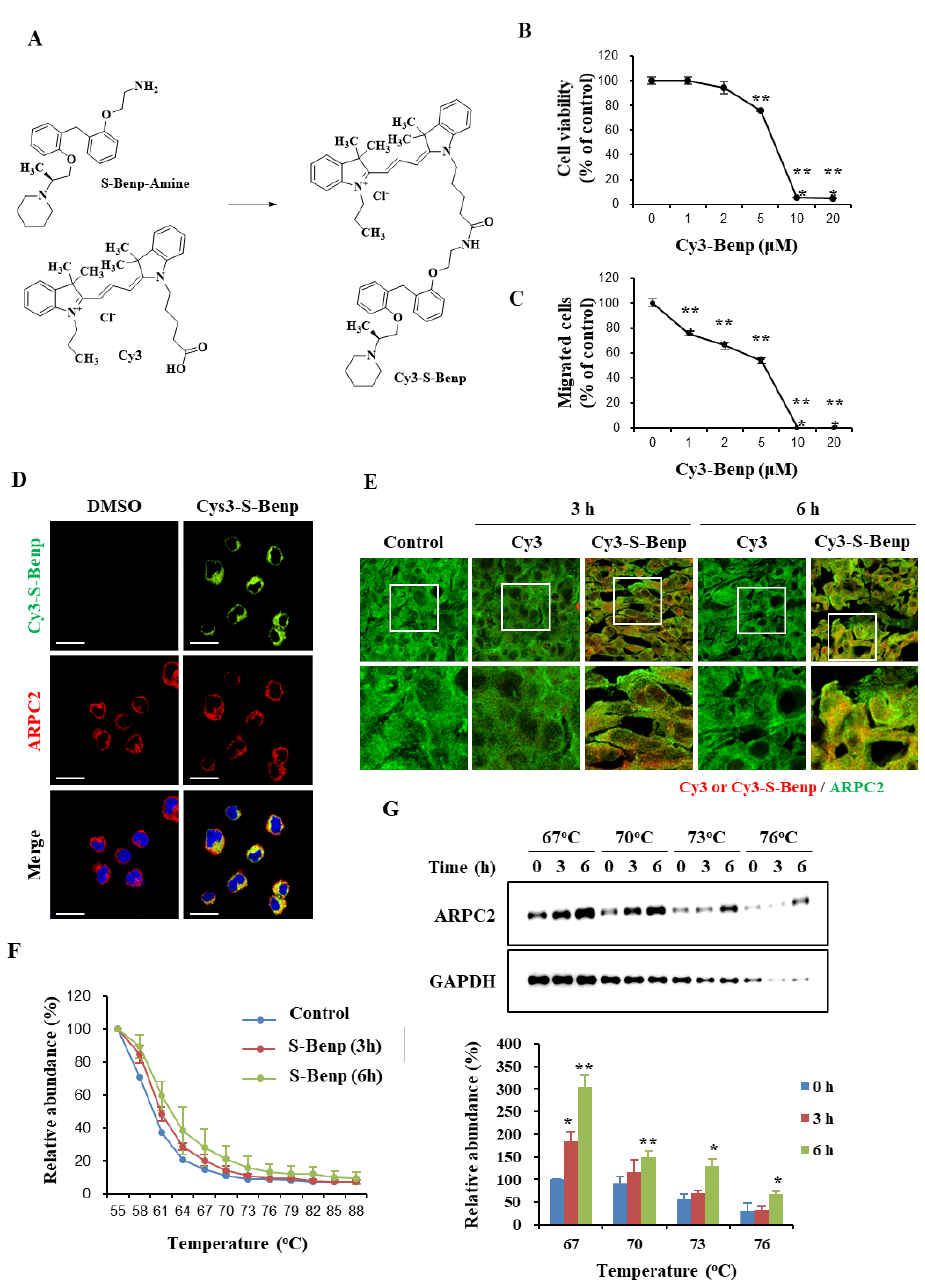
Figure 6. S-Benp localization and binding to ARPC2 in vitro and in vivo. ( A ) Synthesis of Cy3-S- conjugated benproperine (Cy3-S-Benp). ( B ) The viability of AsPC-1 cells that were treated with DMSO or Cy3-S-Benp for 24 h was measured using WST-1 ( n = 3). ( C ) Cell migration assay of AsPC-1 cells that were treated with DMSO or various concentrations of Cy3-S-Benp for 24 h ( n = 3). ( D ) Intracellular distribution of Cy3-S-Benp in AsPC-1 cells that were replated on fibronectin-coated plates for 1 h. The immunofluorescence analysis of ARPC2 following a 1 h treatment with DMSO or Cy3-S-Benp (2 µM) is shown ( n = 2). Scale bars, 20 µm. ( E ) Colocalization of Cy3-S-Benp and ARPC2 in pancreatic tumor tissues at 3 or 6 h after intravenous injection of free Cy3 or Cy3-S-Benp ( n = 2). ( F , G ) A cellular thermal shift assay was performed on tumor tissue lysates with increasing temperature (55 °C to 88 °C, interval temperature: 3 °C). Quantification of the soluble proteins immunoblotted for ARPC2 at the indicated temperature ( n = 2 per group). The data represent means ± s.d.; comparisons were performed with t tests (two groups); * p < 0.05, ** p < 0.01.